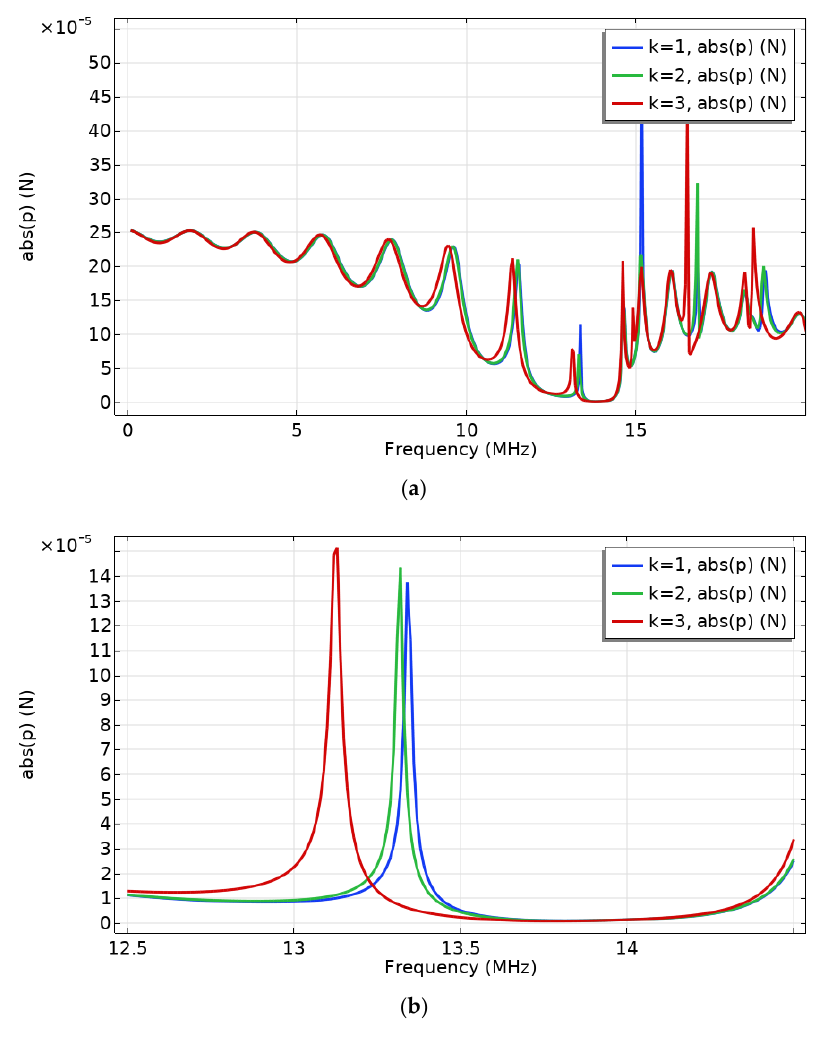
Figure 4. Frequency domain response at 293.15 K (k = 1, 2, 3 correspond to the liquid sound velocity = 1500, 1490, 1420 m/s, which may correspond to the sound velocity values of aqueous solutions of different concentrations of a specific solvent/different solvents of a specific concentration). ( a ) Response for the range 0.1 − 25 MHz. ( b ) Response for the range 12.5 − 14.5 MHz (where the edge of the phononic bandgap is located).